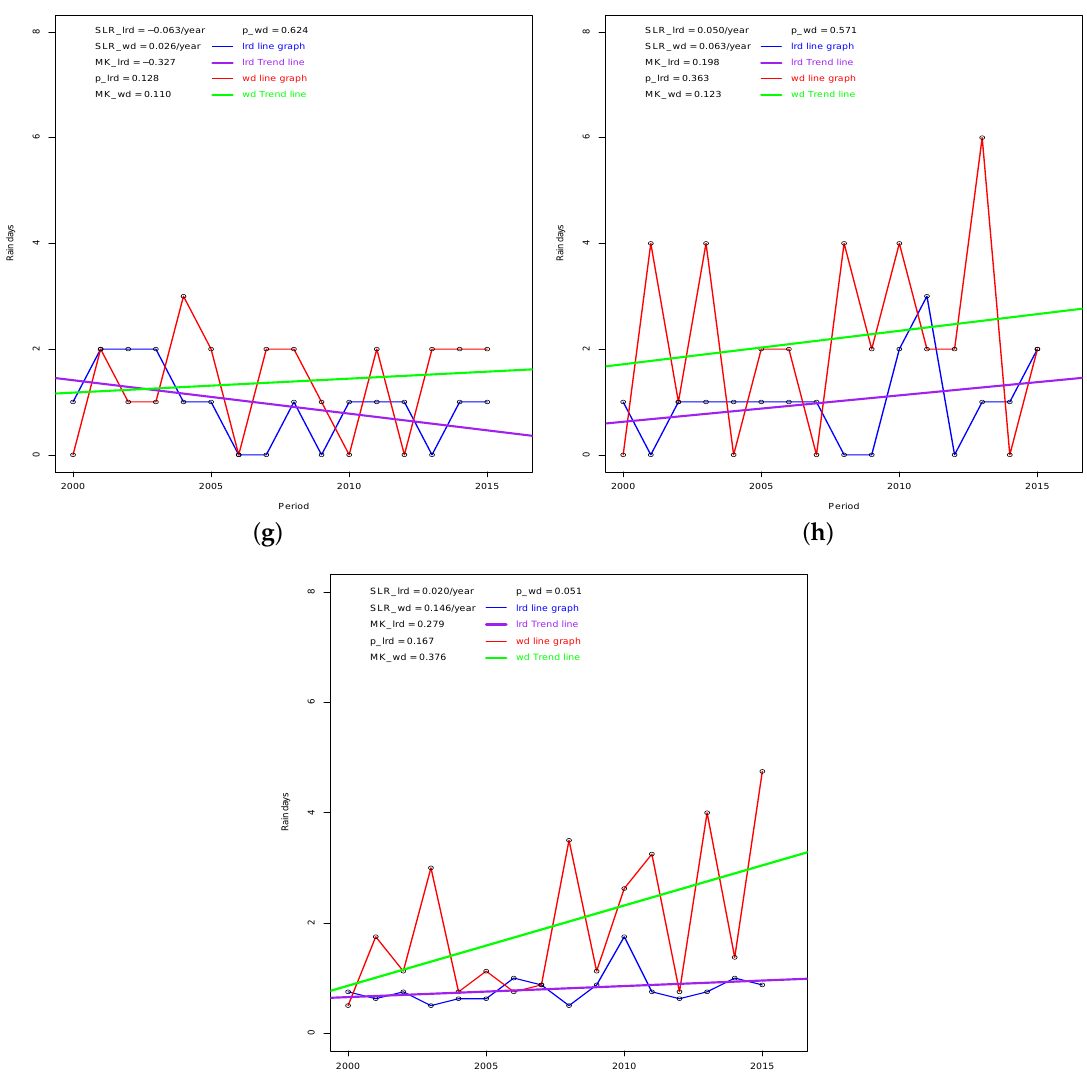
Figure 4. The figure represents the analysis of the light rain days and wet days over the third dekad. The vertical axis is the number of rain days, and the horizontal axis is the period. ( a ) Entebbe; ( b ) Jinja; ( c ) Kamenyamigo; ( d ) Kituza; ( e ) Makerere; ( f ) Namulonge; ( g ) Ntusi; ( h ) Tororo; ( i ) Average over the entire region representing the